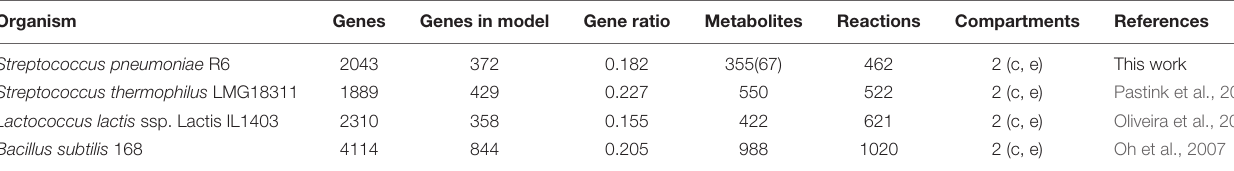
TABLE 4 | Comparison of i DS372 model from S. pneumoniae strain R6 with several other published models. Organism Genes Genes in model Gene